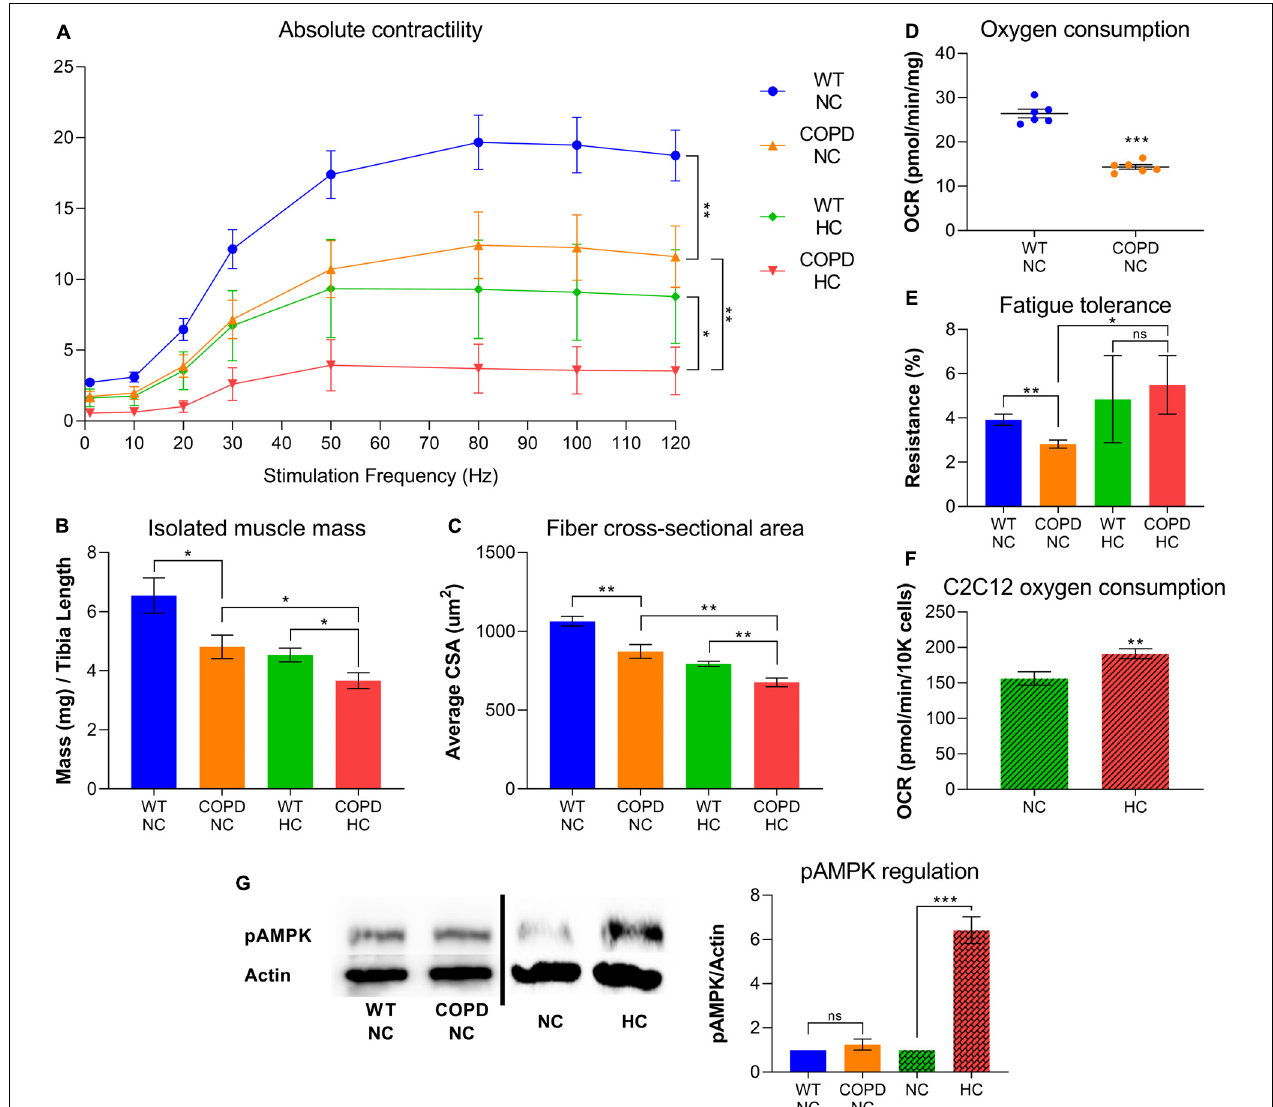
FIGURE 1 | COPD and hypercapnia synergistically contribute to muscle atrophy, but they are antagonistic processes regarding fibers respiratory capacity. (A) Isolated EDL muscle contractility indicates that murine COPD (orange line) causes reduced absolute force-generation compared with wild type (WT) animal (blue line), which is incremented by hypercapnia (green line) and even further by the combination of hypercapnia and murine COPD (red line). Absolute force-generation capacity reflects muscle work dependent on muscle mass ( n = 4). (B) Isolated EDL muscle mass and (C) fibers average cross-sectional area (CSA) follow the same incremental pattern of COPD and hypercapnia described in (A) ( n = 4). (D) Oxygen consumption rate (OCR) by plate respirometry obtained with Seahorse § technology demonstrates that EDL muscle reduced respiratory capacity induced by normocapnic murine COPD ( n = 6). (E) Fatigue-tolerance, which partially depends on the fibers oxidative capacity, is reduced in normocapnic (NC) murine COPD versus wild type (NC-WT) animal ( n = 4). However, the exposure of these animals to hypercapnic (HC) conditions leads to an improvement of their fatigue-tolerance ( n = 4). (F) OCR by plate respirometry obtained with Seahorse § technology indicates that C2C12 cells grown for 48 h in hypercapnic conditions demonstrate elevated respiratory capacity ( n = 7). (G) Activation of AMPK, as reflected by its phosphorylation at threonine 172 (pAMPK) is not evident in the COPD animal but robustly demonstrated by muscles from animals exposed to hypercapnia ( n = 4), * p < 0.05, ** p < 0.01, *** p < 0.001. For technical details about the methods, see our recent publications (Jaitovich et al., 2015; Balnis et al., 2020a,b,c; Korponay et al., 2020). Presented data is original and thus has not been previously